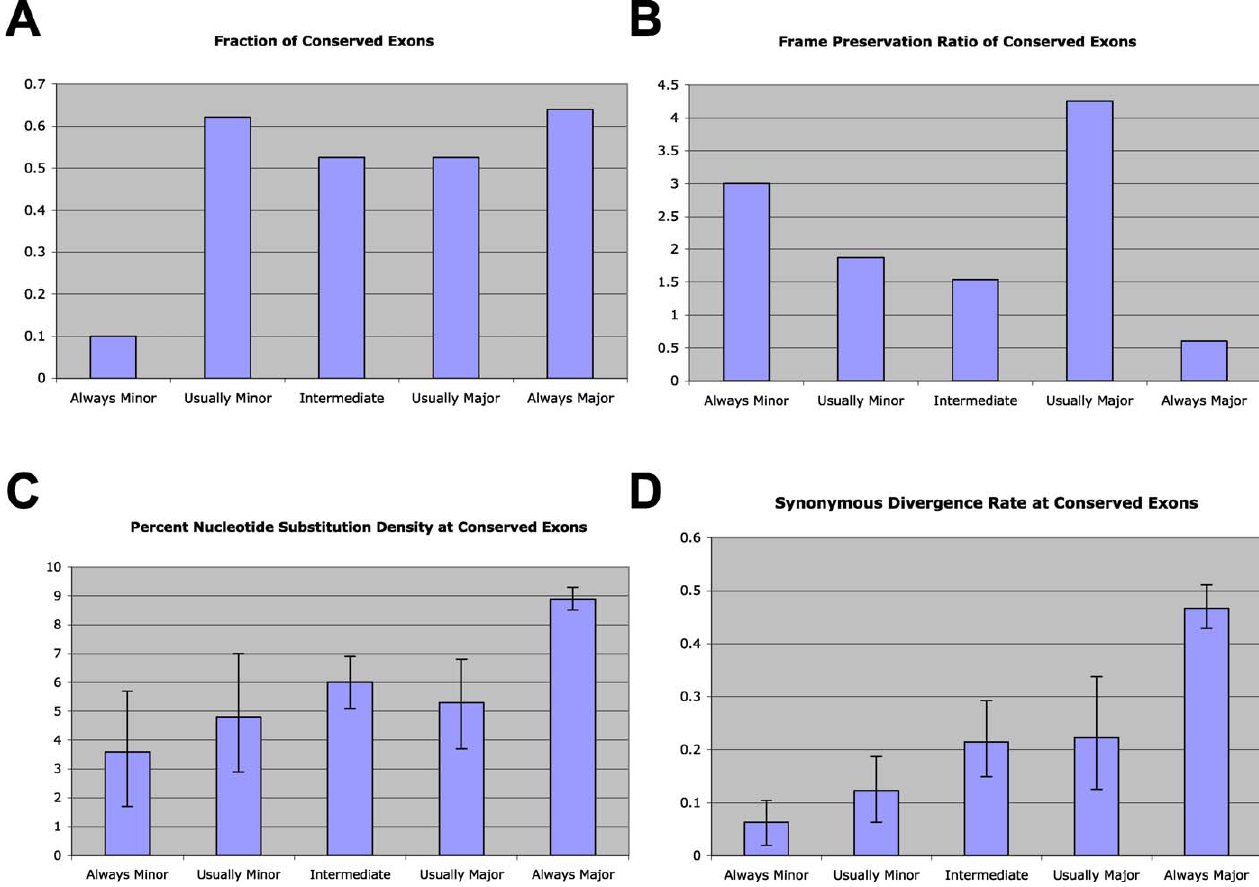
Figure 1. Increased Functional Constraints Are Associated with All Types of Tissue-Switched Exons (A) The fraction of exons conserved between human and mouse for each exon category. All types of tissue-switched exons (usually major, intermediate, usually minor) showed a high rate of conservation. (B) The frame-preservation ratio for each category of exons. Protein reading frame preservation is associated with all types of tissue-switched exons and conserved, always minor exons. Conserved, always major exons showed no evidence for increased protein reading frame preservation. (C) The percent nucleotide substitution density for each exon category. All types of tissue-switched exons showed a reduced nucleotide-sequence substitution density between human and mouse, similar to what is observed for conserved, always minor exons. Error bars represent 95% confidence intervals obtained from nonparametric bootstrapping. (D) The nucleotide substitution rate calculated for synonymous sites (Ks) from human and mouse orthologous exon sequences (see Materials and Methods). All types of tissue-switched exons showed reduced K s rates between human and mouse, similar to what is observed for conserved, always minor exons. Error bars represent 95% confidence intervals obtained from nonparametric bootstrapping. DOI: